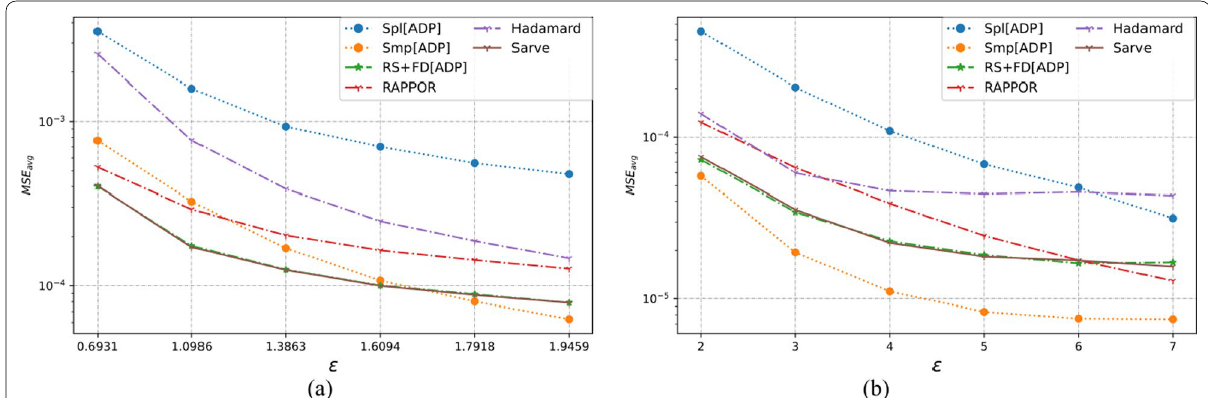
50,000, D 5 privatized using different randomization techniques and fake data = =